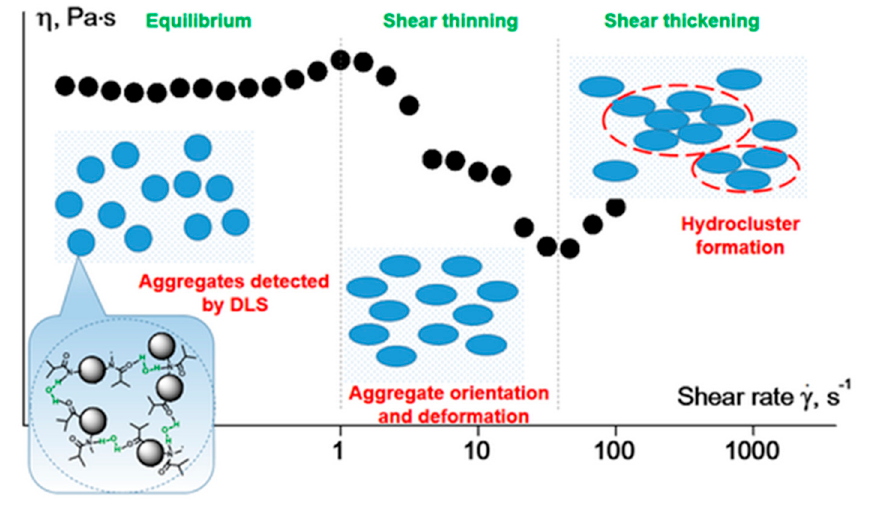
Figure 10. The jamming of hydroclusters in a flow.